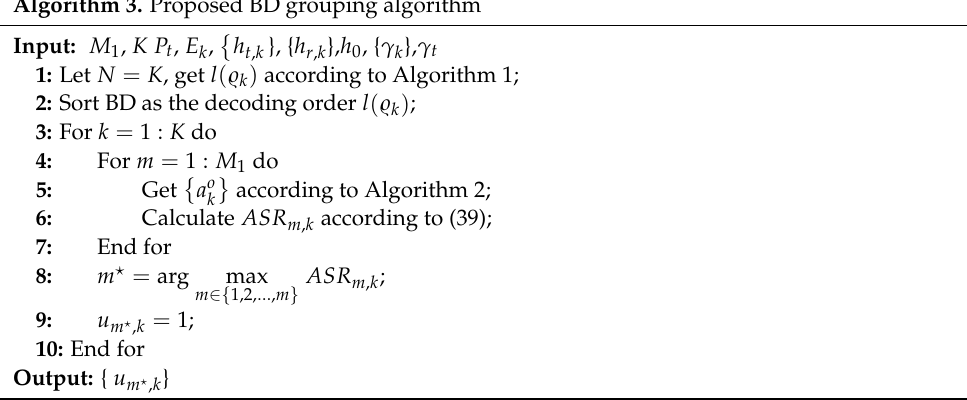
Algorithm 3. Proposed BD grouping